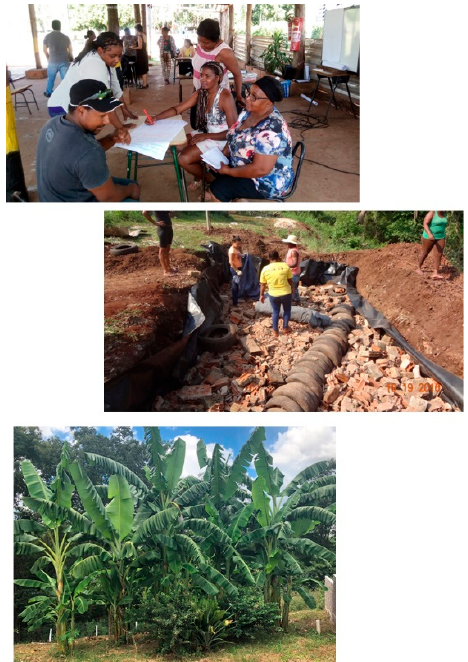
Figure 4. Monitoring & control: decision-making process, implementation of the chosen alternative and 18 months after construction. Consent for publishing these photos was obtained.